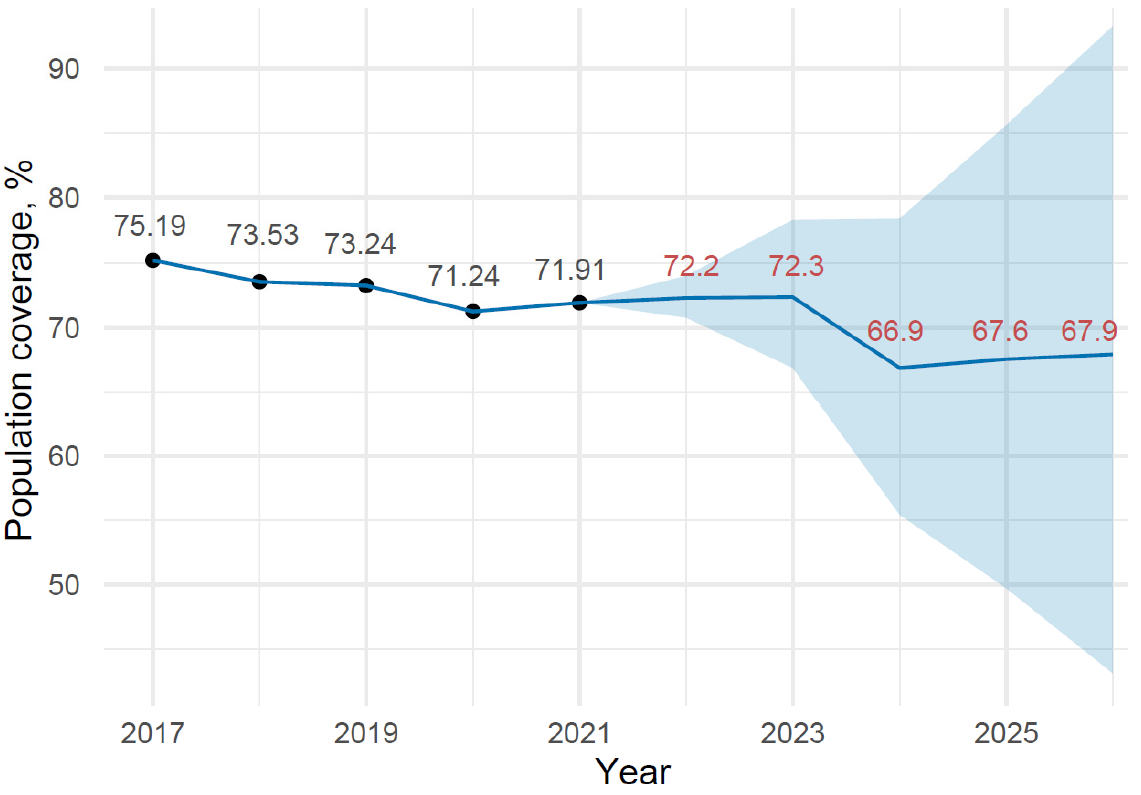
Figure 2. Population coverage and projection of CC screening in private health care from 2014 to 2021, with Prophet algorithm predictions for 2022–2026.